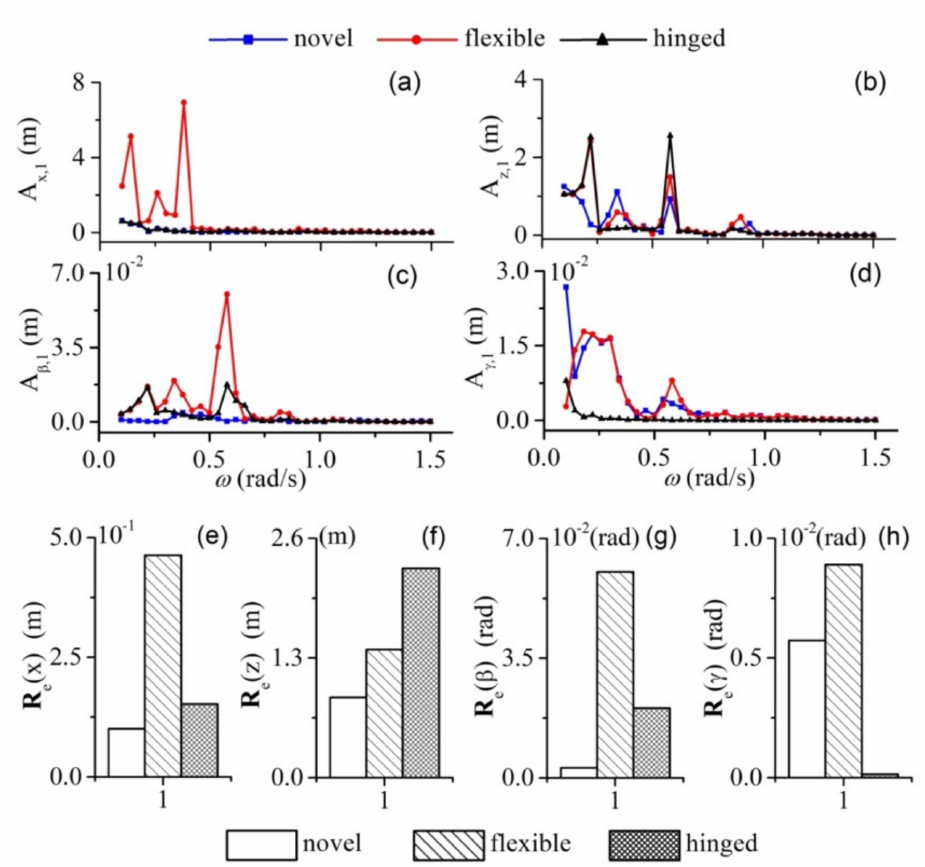
Figure 8. For the wave incident angle 45 ◦ , the responses amplitudes of the first module in the ( a ) surge, ( b ) heave, ( c ) pitch, and ( d ) yaw responses versus the regular wave frequency and the amplitudes of 1–in–1000 extreme responses of the ( e ) surge, ( f ) heave, ( g ) pitch, and ( h ) yaw motions in random